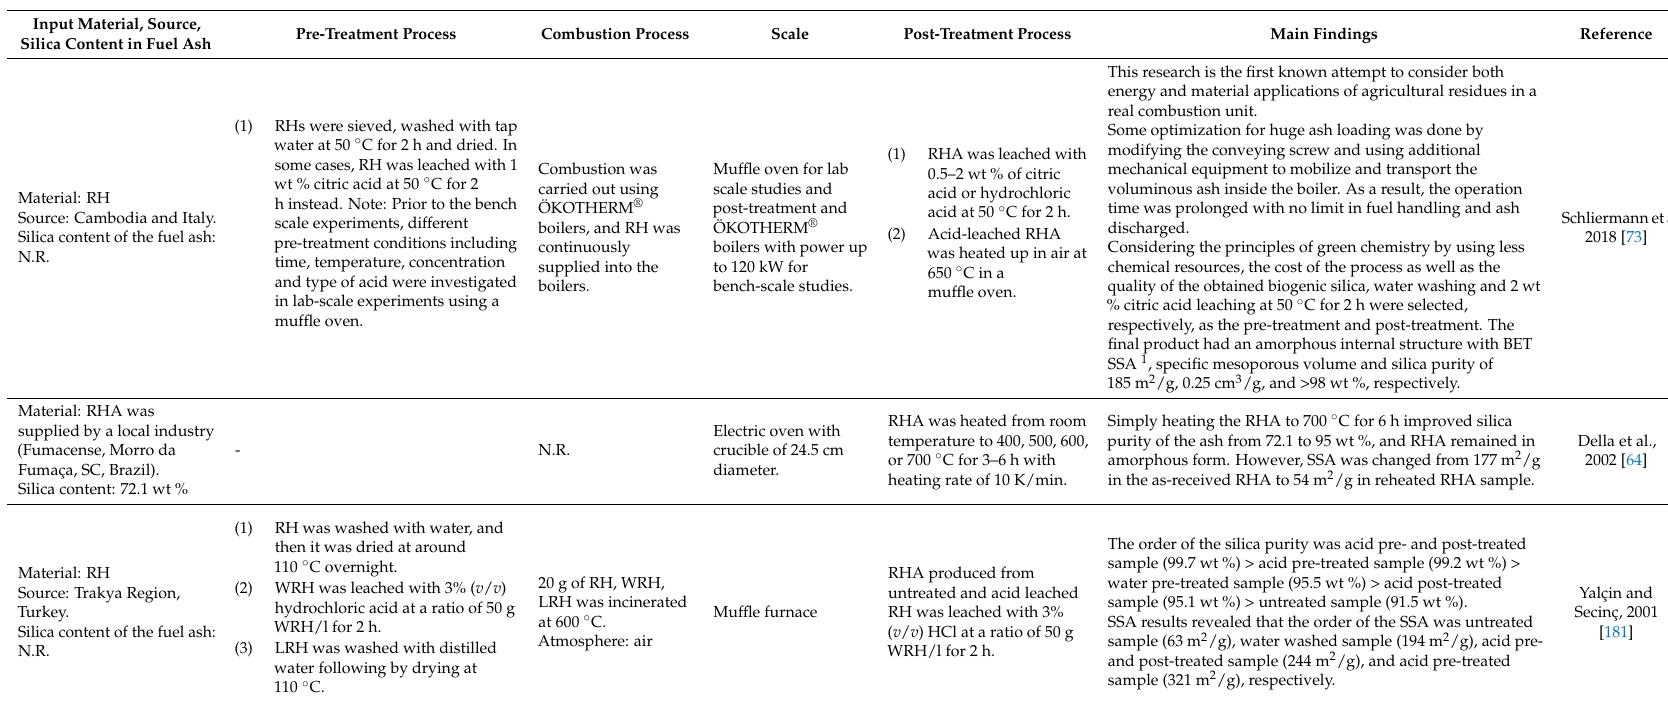
Table 6. Combination of ash post-treatment with fuel pre-treatment and combustion to obtain pure biogenic silica from RH and